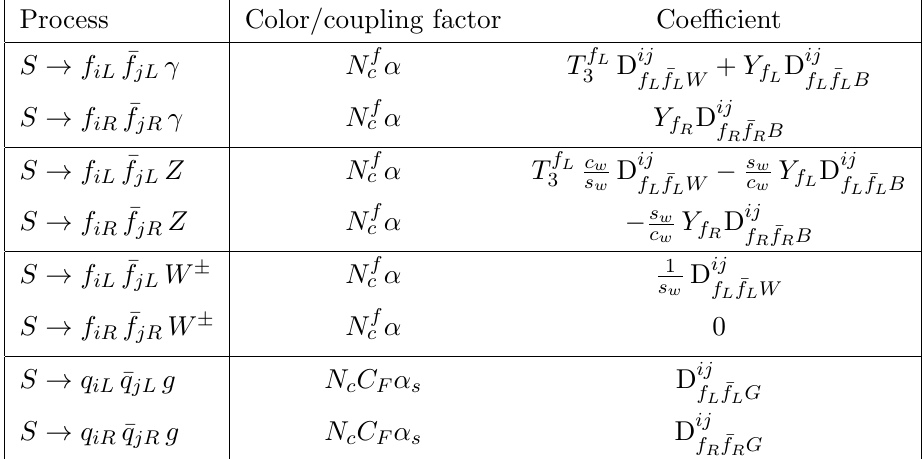
f iL (cid:22) f jL V and S f iR (cid:22) f jR V , all of ! !